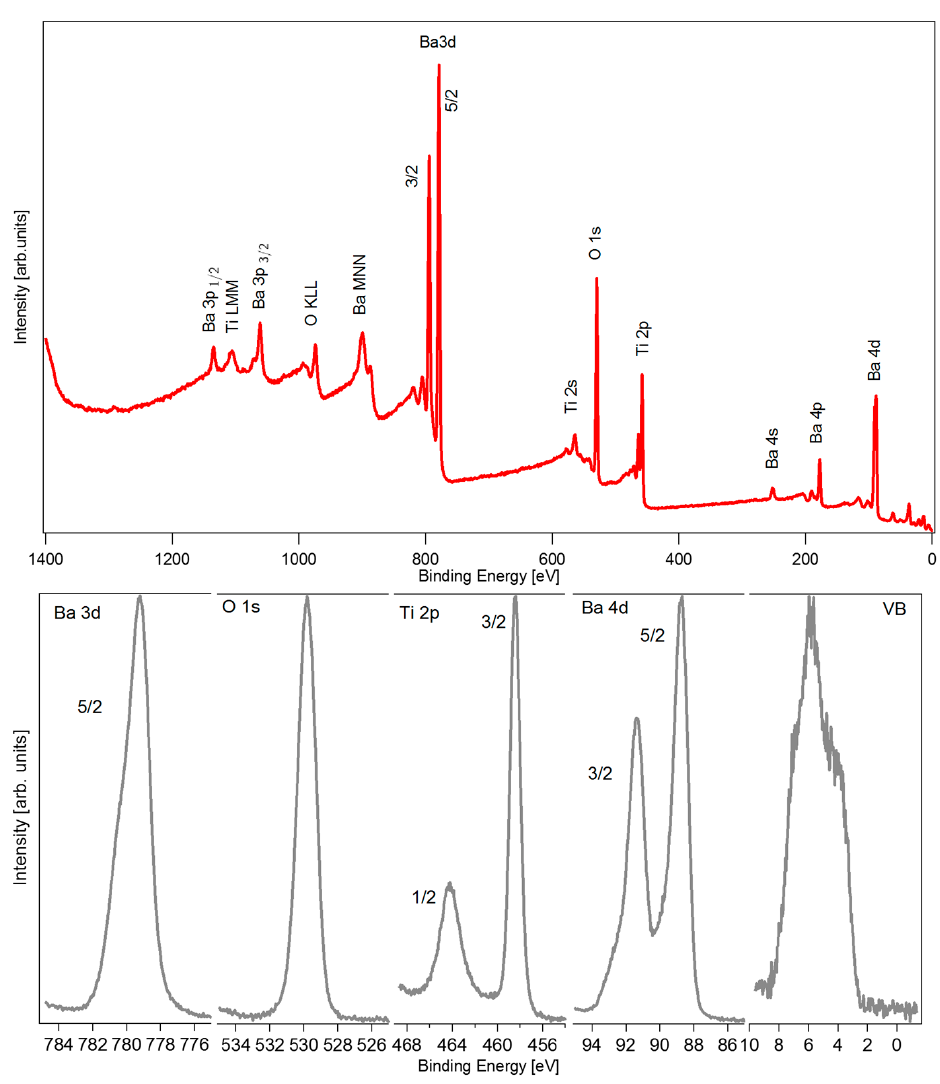
Figure 4. Dielectric permittivity and dielectric losses vs. frequency (V osc = 0.01 V) of (un)doped samples and different multilayer heterostructures at 293 K.